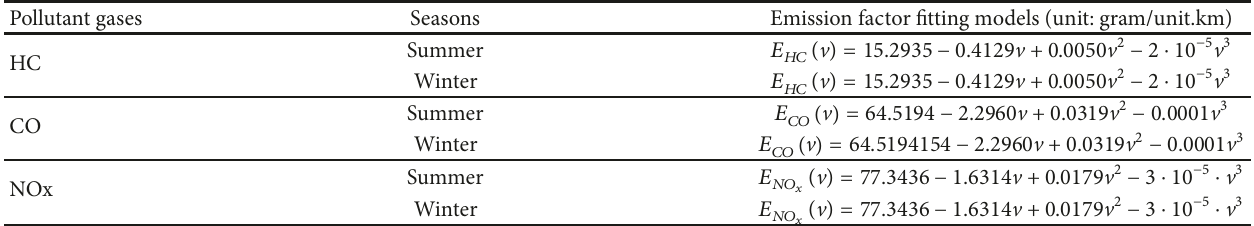
Table 1: Fitting models based on comprehensive emission factor of HC, CO, and NOx for